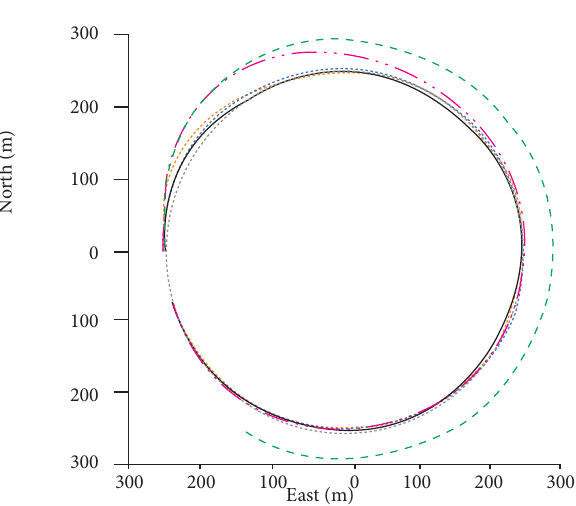
Figure 7. Ten-meter cross track in linear tracking ability.